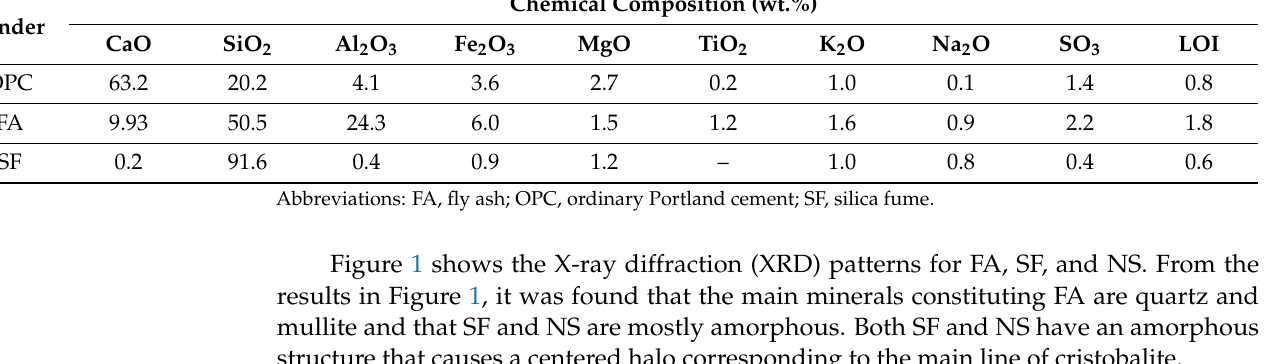
Table 1. Chemical composition of binders.